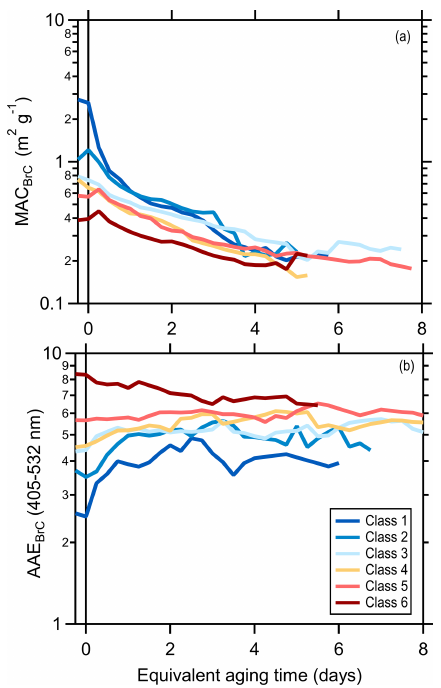
Figure 2. Relationship between the brown carbon (a) MAC BrC and (b) AAE BrC as a function of equivalent photochemical aging time (assuming [OH] = 1 . 5 × 10 6 moleculescm − 3 ). The different lines are colored according to the SSA classification and are averages for all burns within a class. Class 1 corresponds to particles having low SSA 405 and class 6 to particles having high SSA 405nm . Figures showing results for each burn are available in the